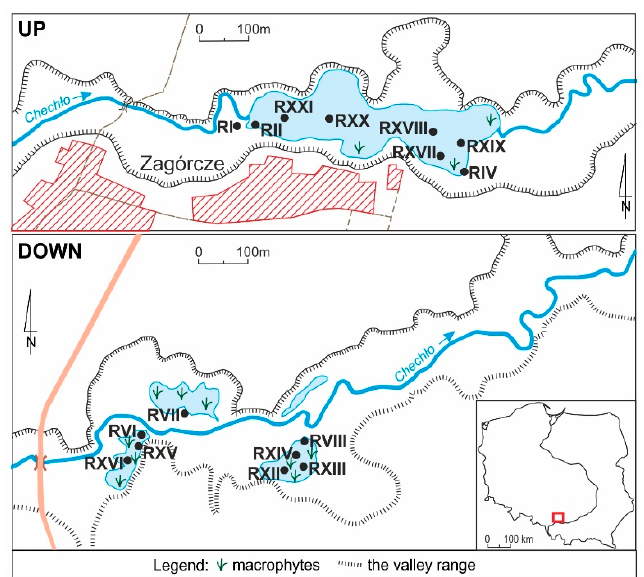
Figure 1. Sampling area (UP: Subsidence pond after the closure of the mine; cores: RI, RII, RIV, RXVII, RXVIII, RXIX, RXX, RXXI; DOWN: Subsidence ponds during peak exploitation; cores: RVI, RVII, RVIII, RXII, RXIII, RXIV, RXV, RXVI).